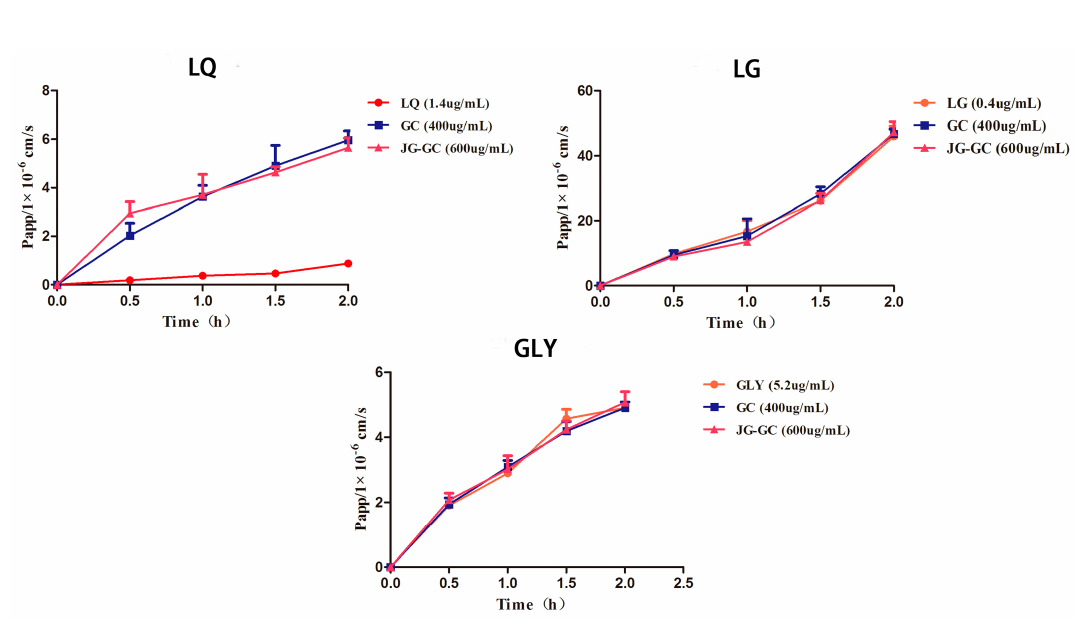
Figure 3. P app profiles for the analytes in different groups (mean ± SD, n = 3).